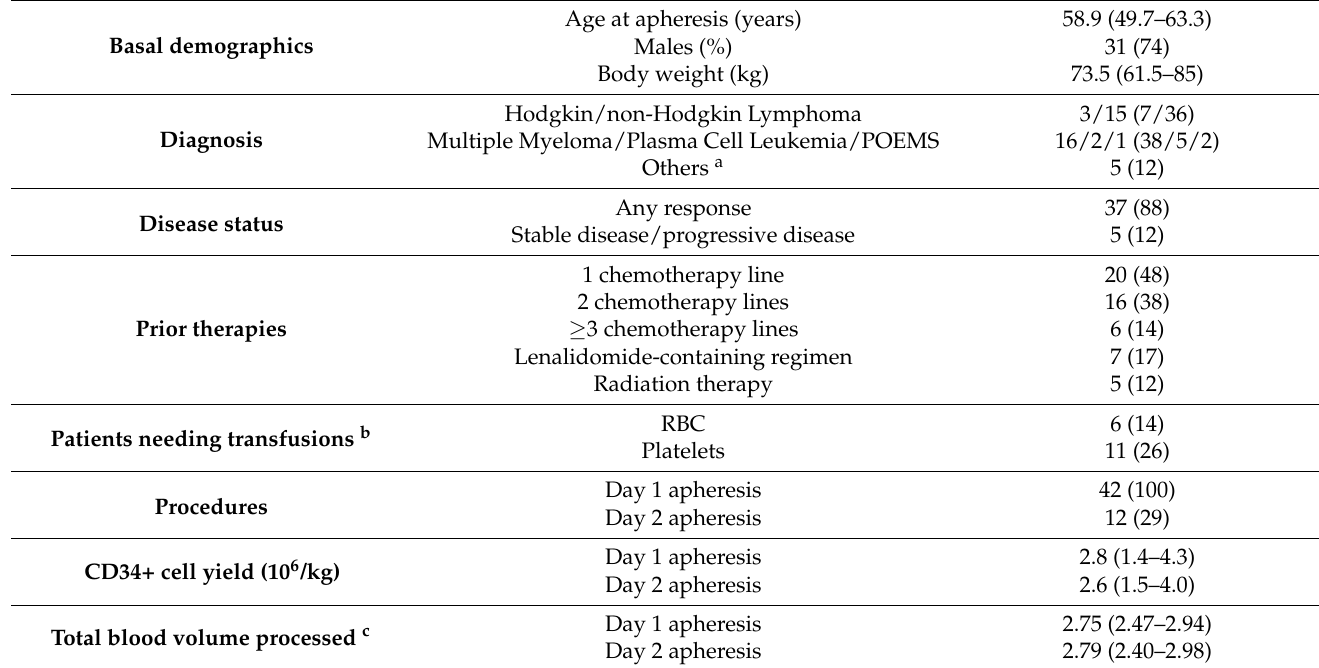
Table 1. Characteristics of 42 investigated patients and 74 overall apheresis.